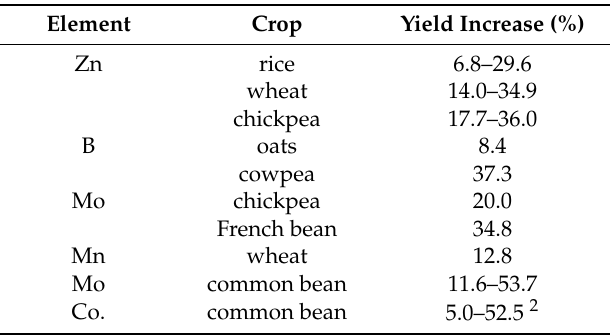
Table 3. Yield increase by seed priming 1